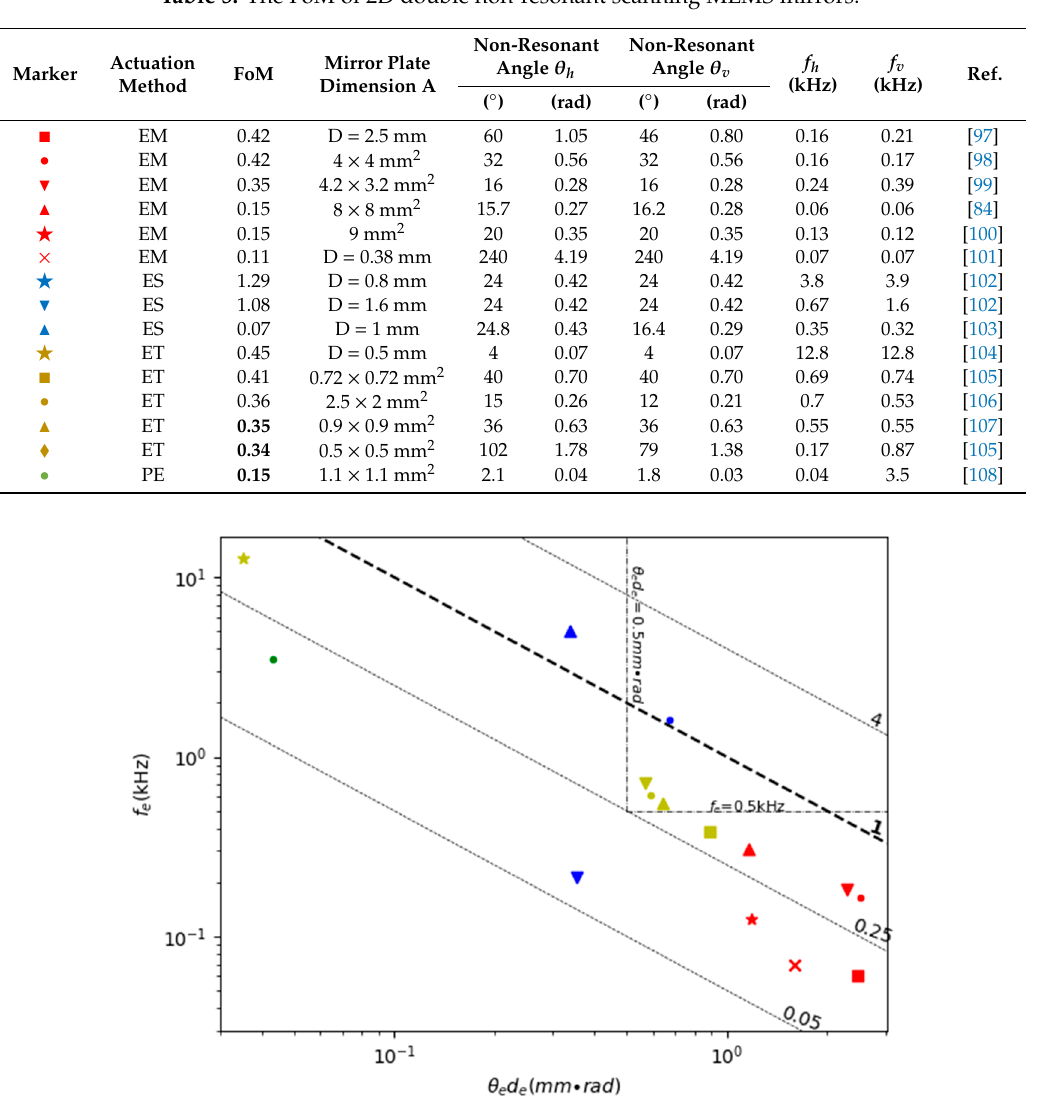
Table 5. The FoM of 2D double non-resonant scanning MEMS mirrors.